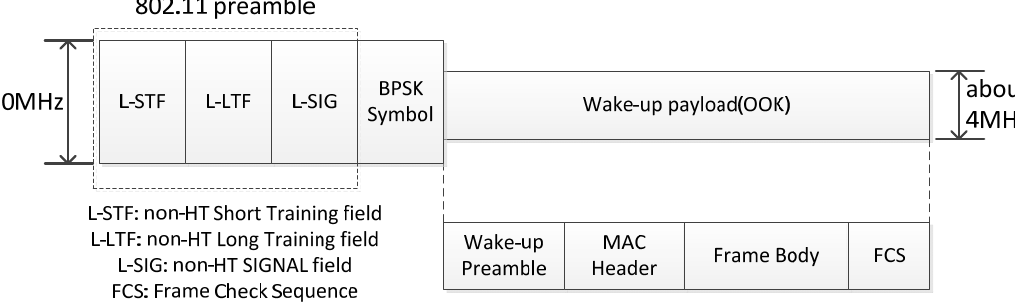
Figure 2. Structure of Wake-up symbol. BPSK = Binary Phase-shift Keying; MAC = Medium Access Control; HT = High Throughput.